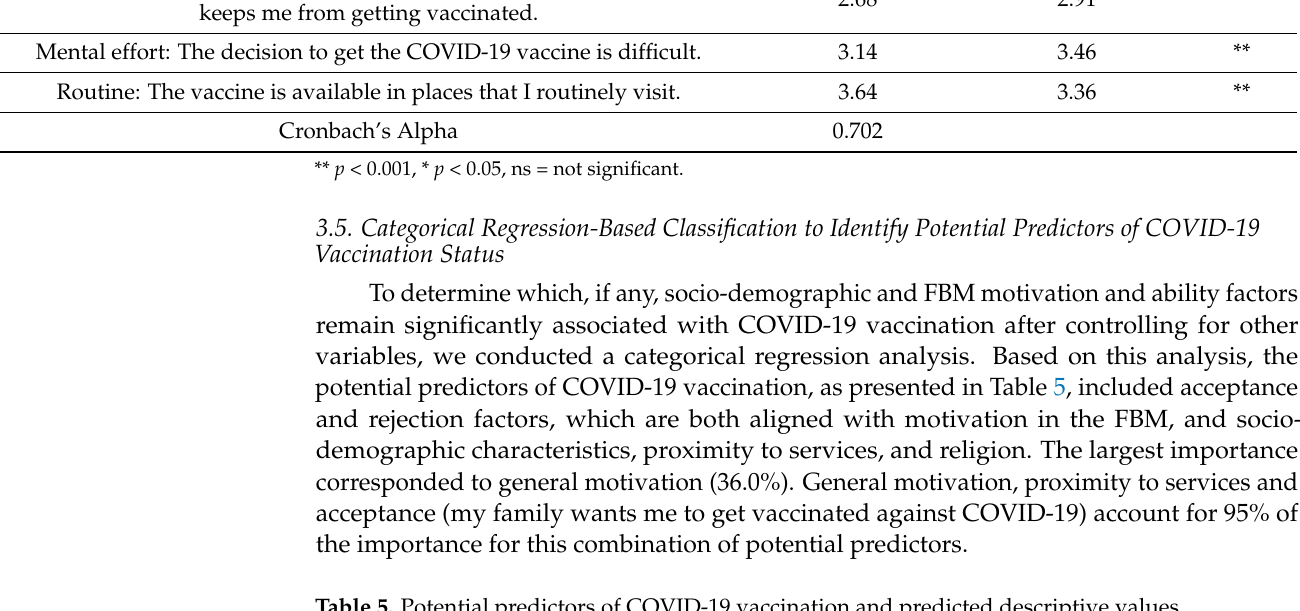
Table 5. Potential predictors of COVID-19 vaccination and predicted descriptive